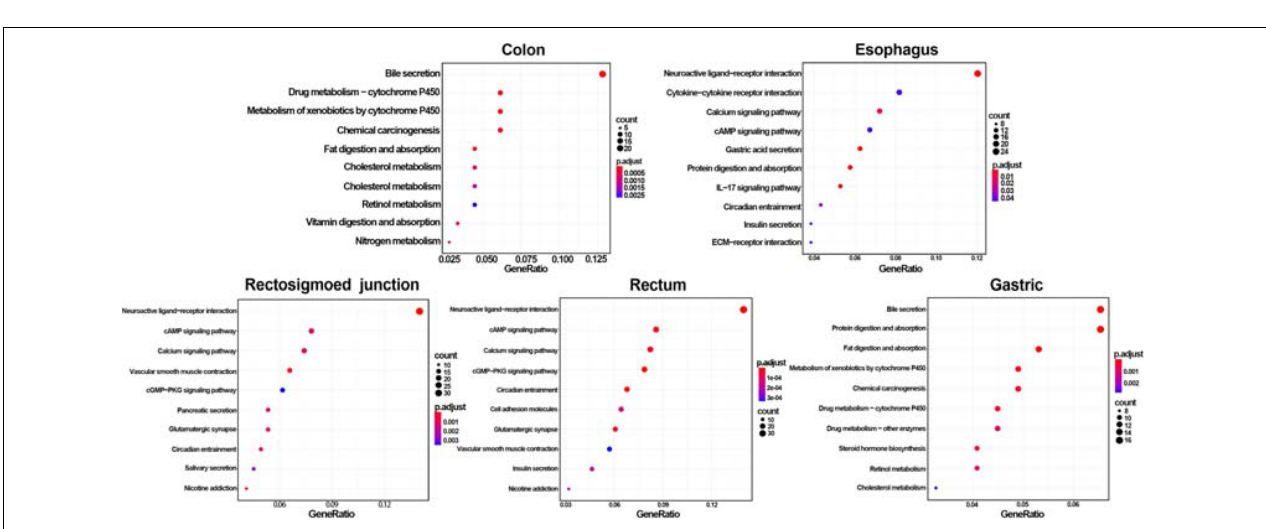
FIGURE 4 | Identification of differentially expressed RNAs and KEGG enrichment of DEmRNAs. The color of the bubble represent the significant of